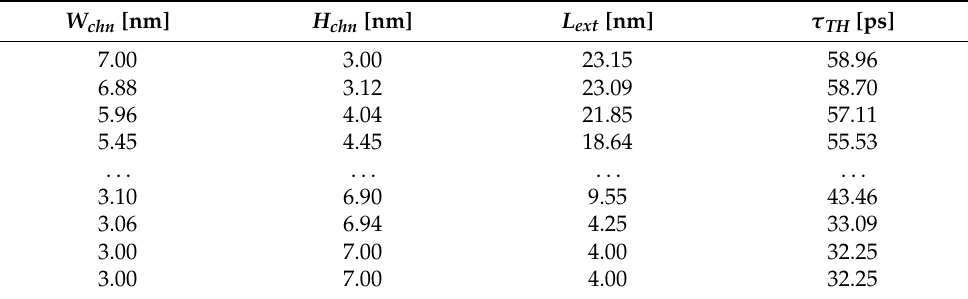
Table 3. Optimization results from the genetic algorithm on the neural network model.